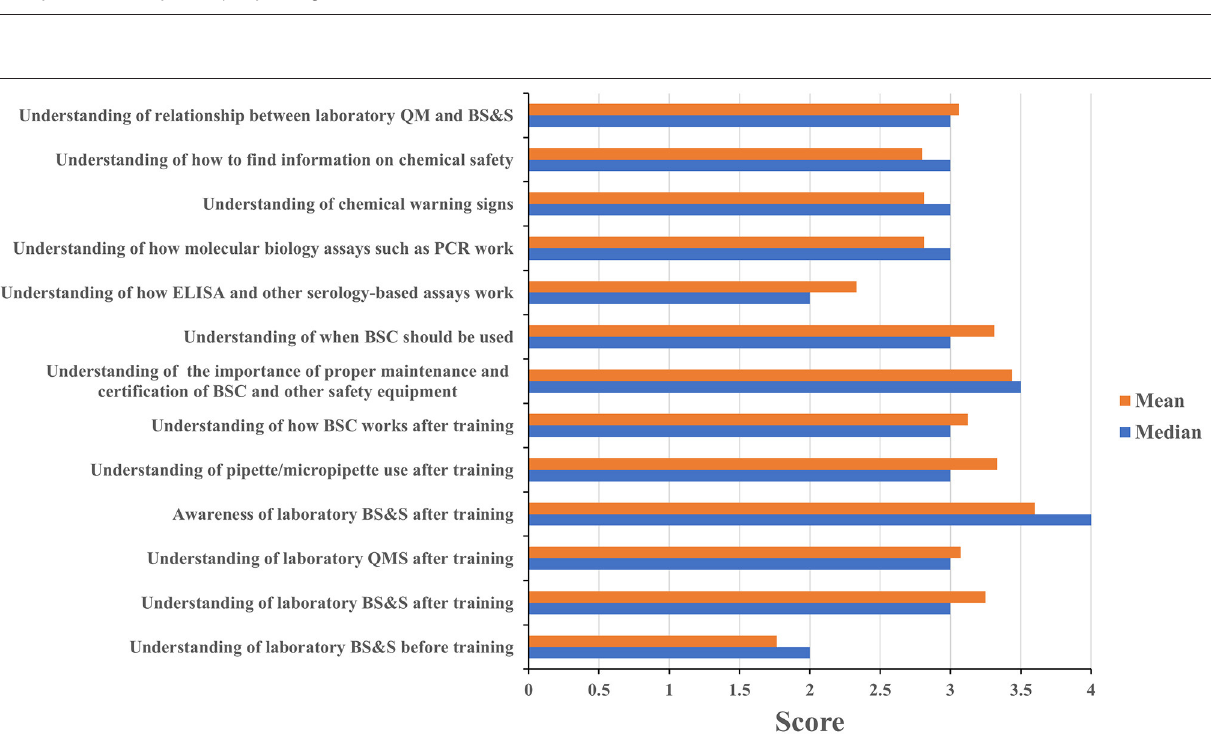
Frontiers in Public Health |